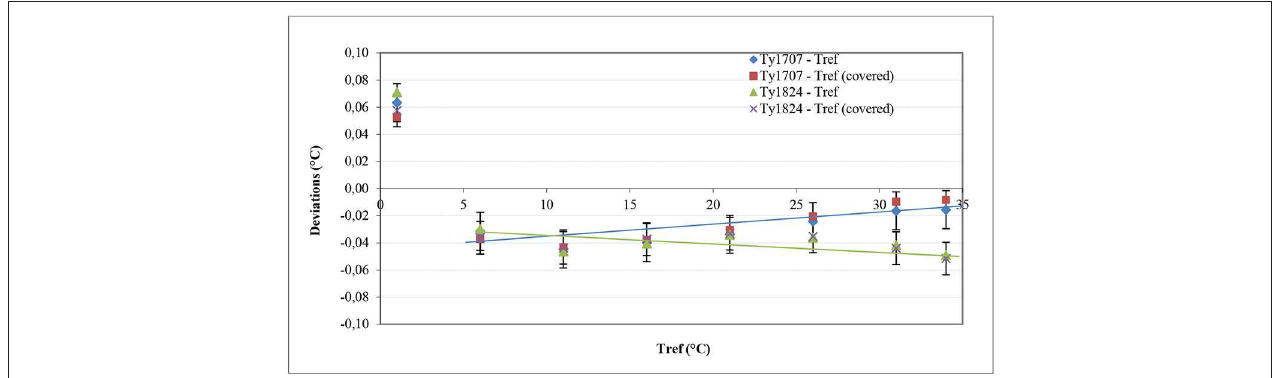
FIGURE 8 | Deviations obtained during the verification of SST sensors of two buoys during the two series, with the expanded uncertainty of the verification.